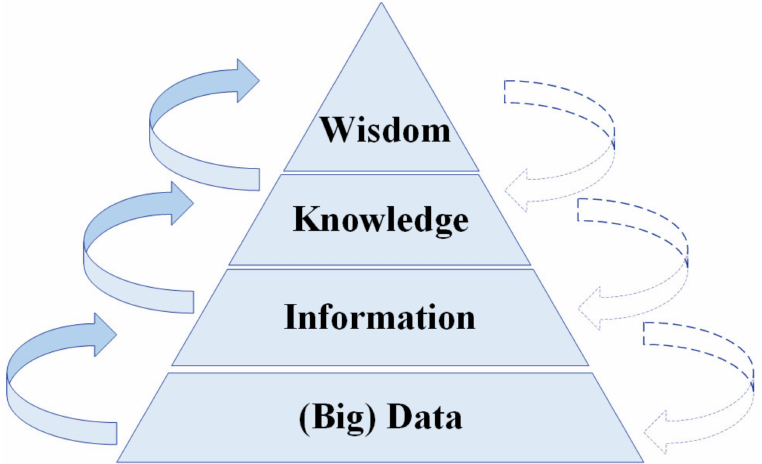
Figure 3. The DIKW hierarchy, from observation to wisdom, is based on